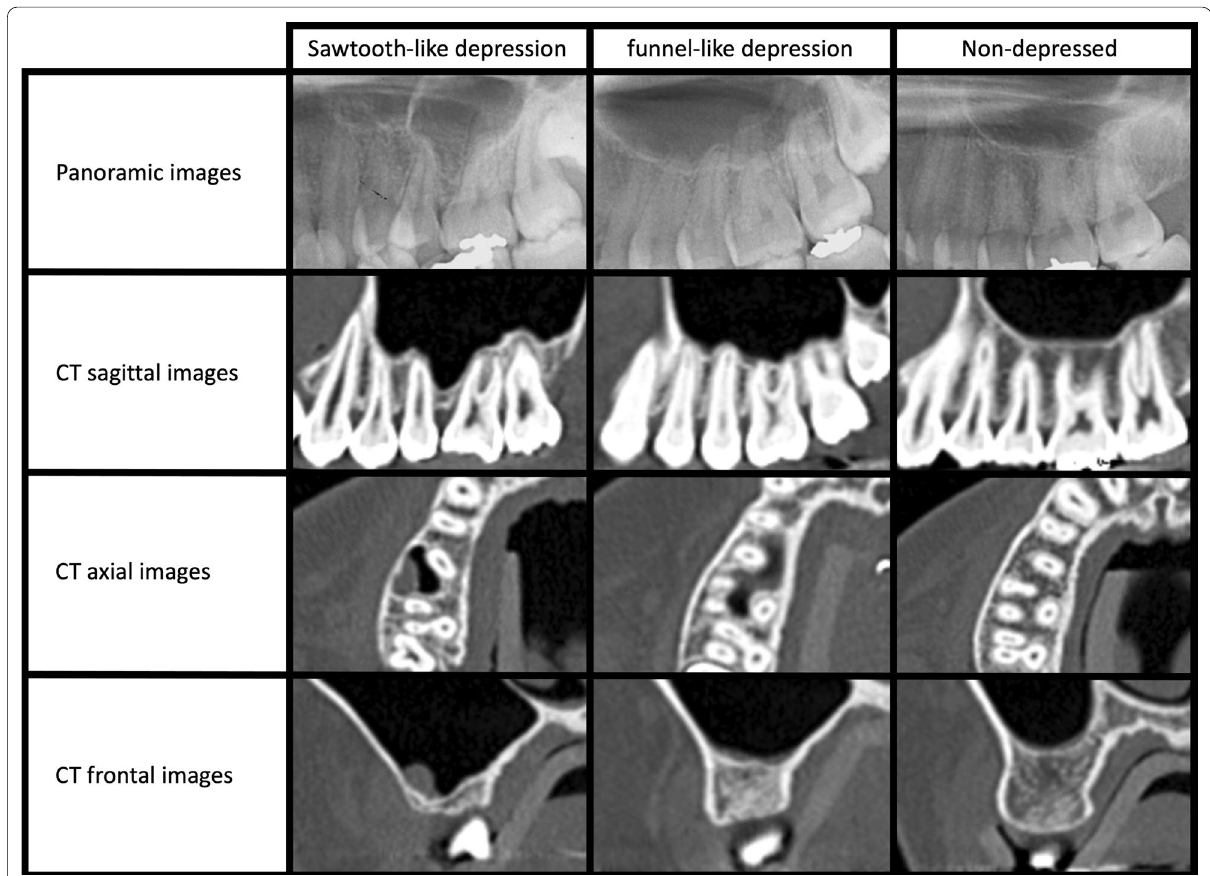
Fig. 2 Representative panoramic images and their corresponding CT images